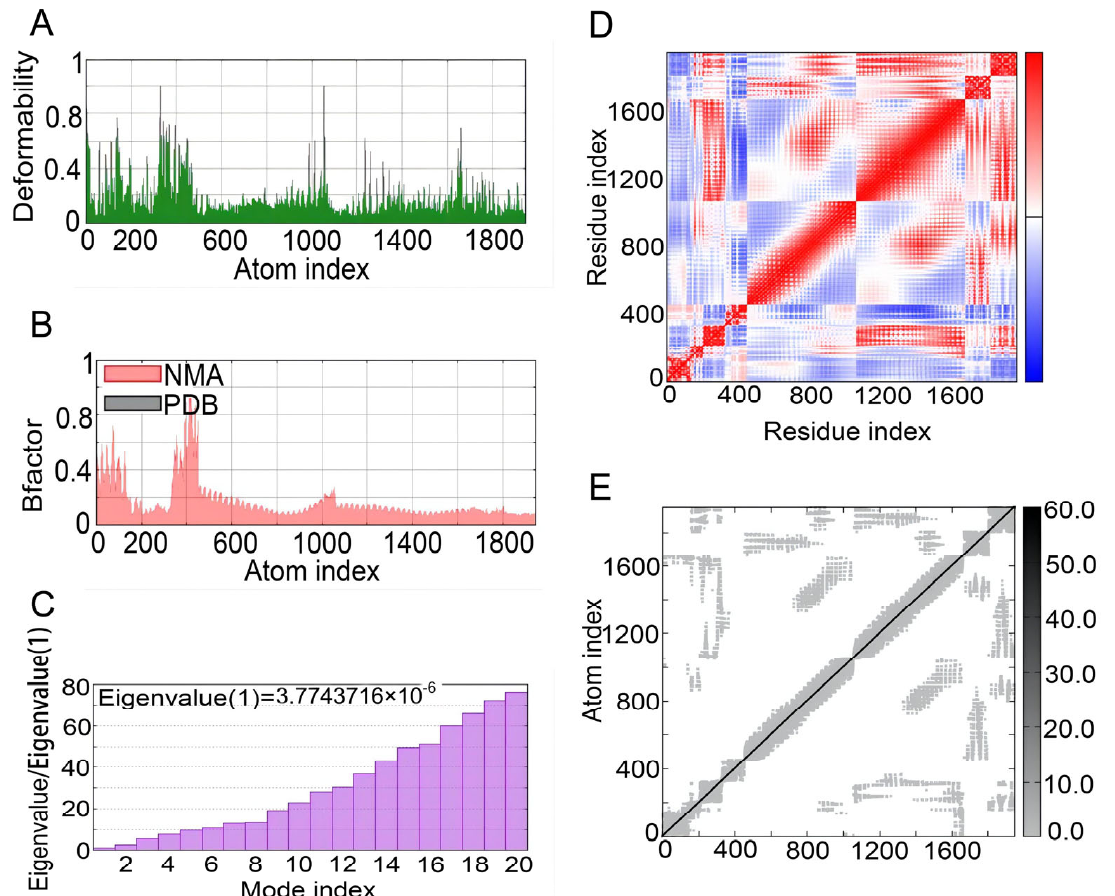
Figure 6. NMA modeling of S7D5L4-TLR4 complexes. ( A ) Modeling the deformability of the main chain. ( B ) B-factor values were calculated using NMA to quantify the uncertainty of all atoms. ( C ) The eigenvalues represent the energy required to deform the structure between adjacent complexes. ( D ) Covariance matrix between residues (red: correlated, blue: anti-correlated, white: uncorrelated). ( E ) Elastic network model between springs and atoms. Darker gray indicates stiffer spring.